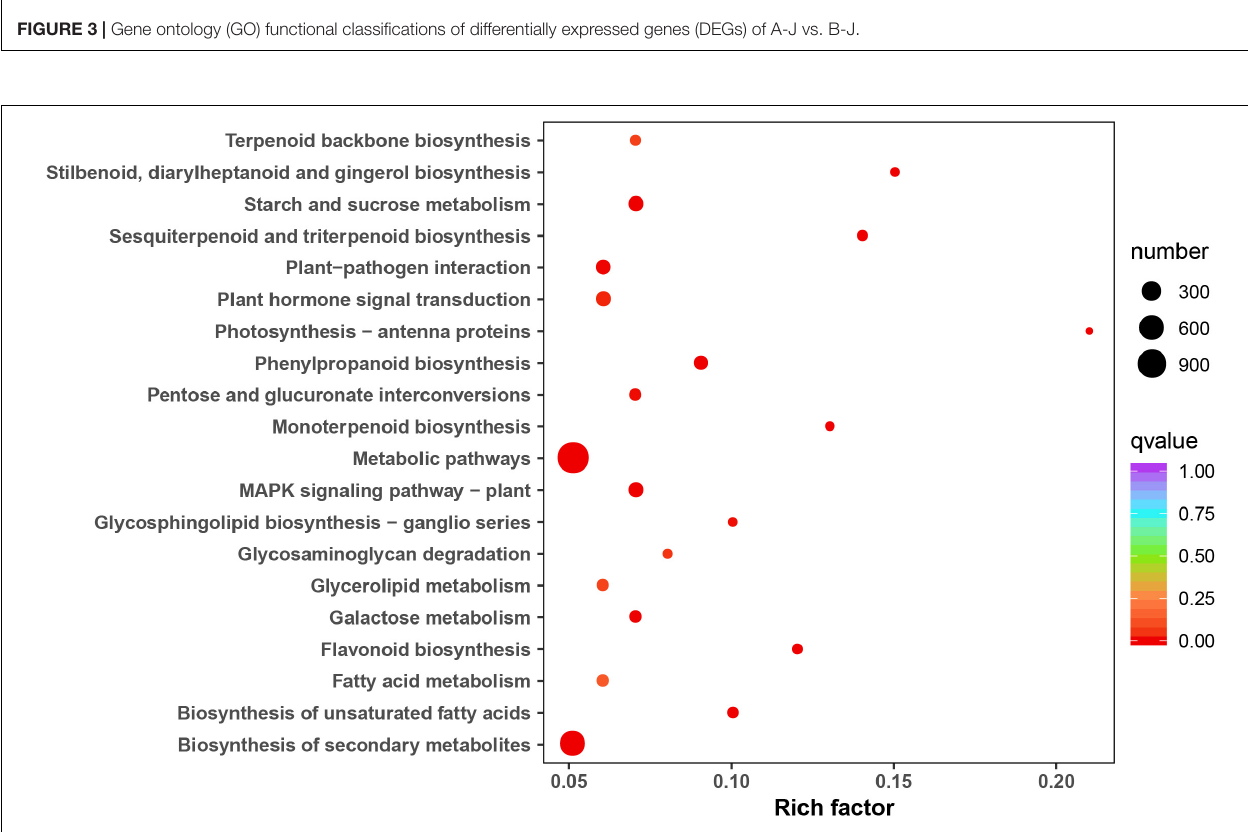
FIGURE 4 | Statistics of KEGG enrichment of A-J vs.